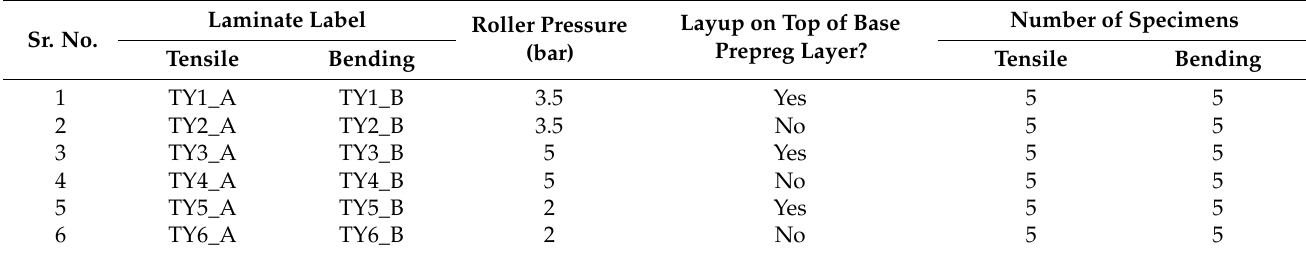
Table 1. Specimen nomenclature based on roller pressure and base prepreg